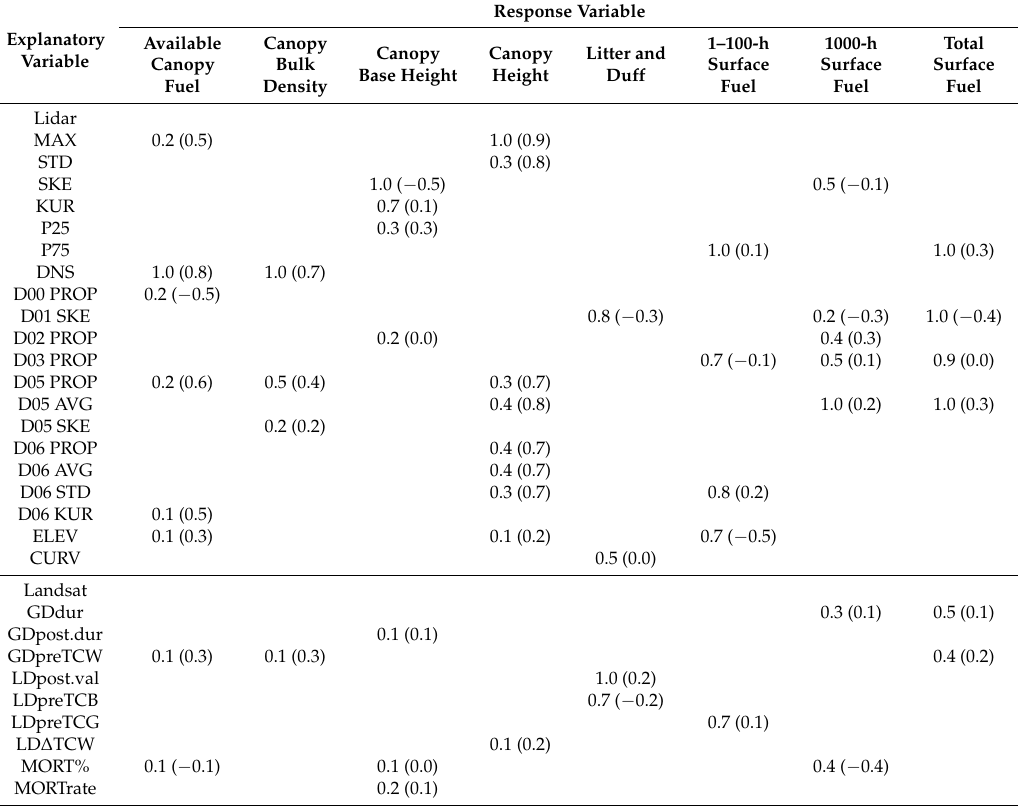
Table 5. Selected explanatory variables, variable importance scores (0–1), and Spearman’s correlation values ( ρ , given in parentheses) of random forest models predicting canopy and surface fuels from lidar and Landsat variables. Variable importance scores of one indicate most important, zero least important. Spearman’s correlation values range from − 1 to 1; negative and positive values indicate negative and positive correlation between response and explanatory variables,